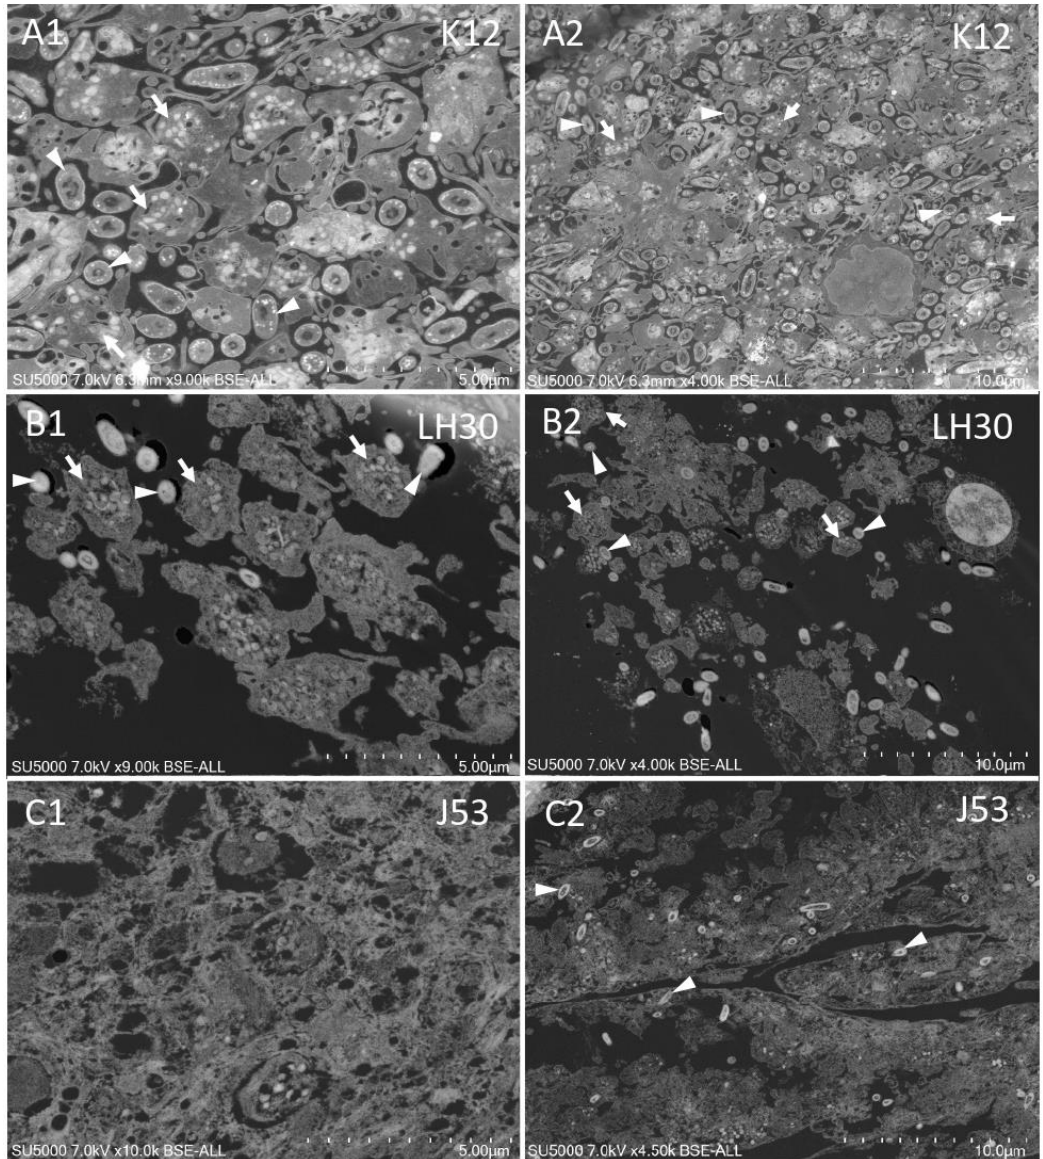
Figure 3. BSE-SEM observation of ultra-thin sections of platelets- E. coli mixtures. ( A1 , A2 ): Platelets and E. coli K12 mixture, ( B1 , B2 ): Platelets and E. coli LH30 mixture; ( C1 , C2 ): Platelets and E. coli J53 mixture. White arrows: platelets, white arrowheads: bacteria. Table 2. Description of whole and sectioned platelets-bacteria aggregates using SEM.